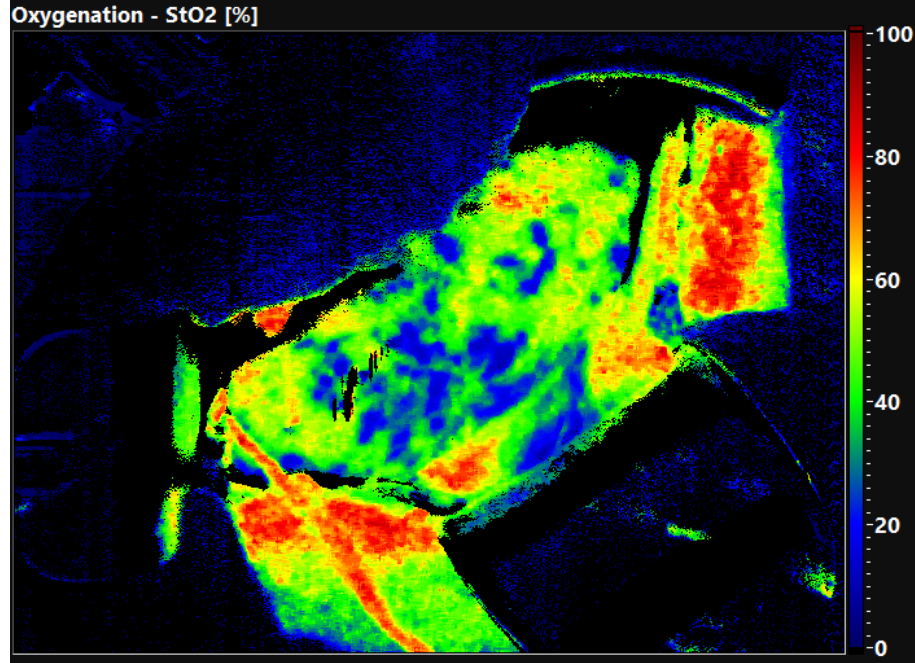
Figure 3. False-color image of a kidney allograft with DGF 30 min after reperfusion. The blue and green colours display a low oxygen saturation (0–40%).